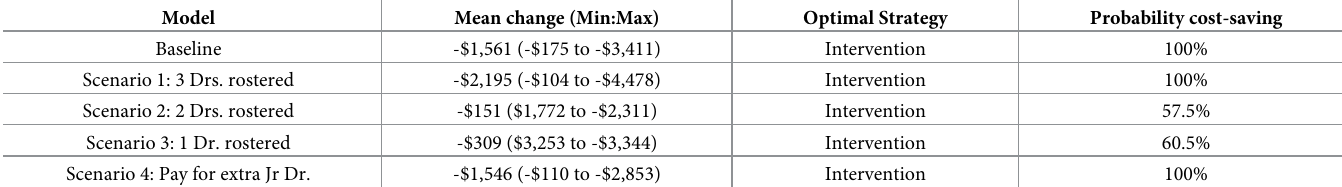
Table 3. Results of the base case analysis and scenario analyses.